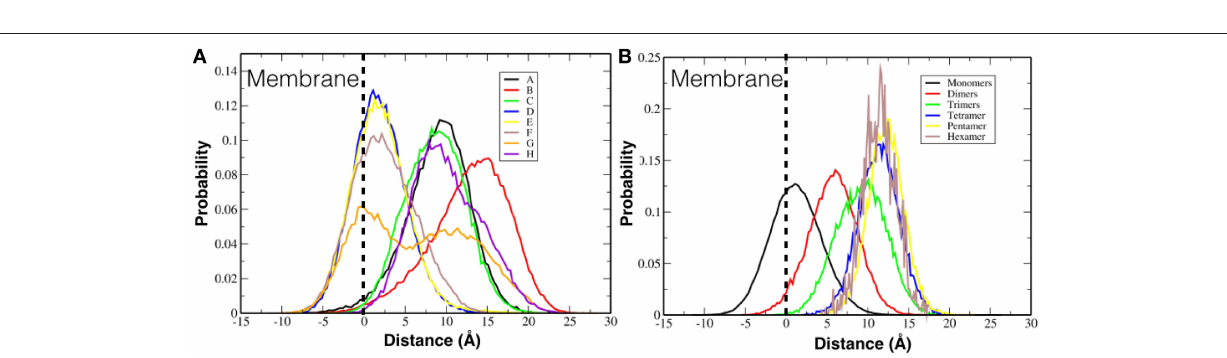
FIGURE 5 | (A) Plot of the number of contacts of the residues of each TFP monomer during the self-assembly of TFP trimers. (B) The residues that are interacting the most during the self-assembly of TFP trimers are highlighted in red on the TFP monomer structure.